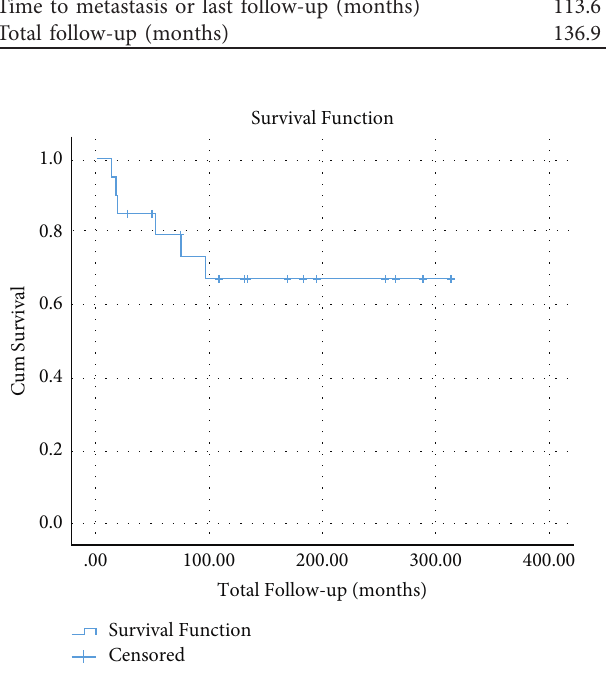
Figure 1: Kaplan–Meier survival curve for all 20 subjects. The 5- year survival was approximately 70%.